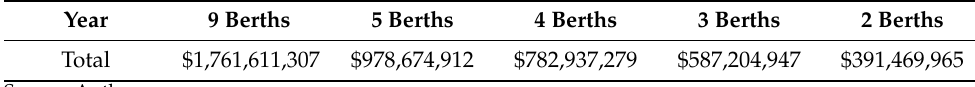
Table 10. Total added value of other port service users (unit: U.S. dollars).